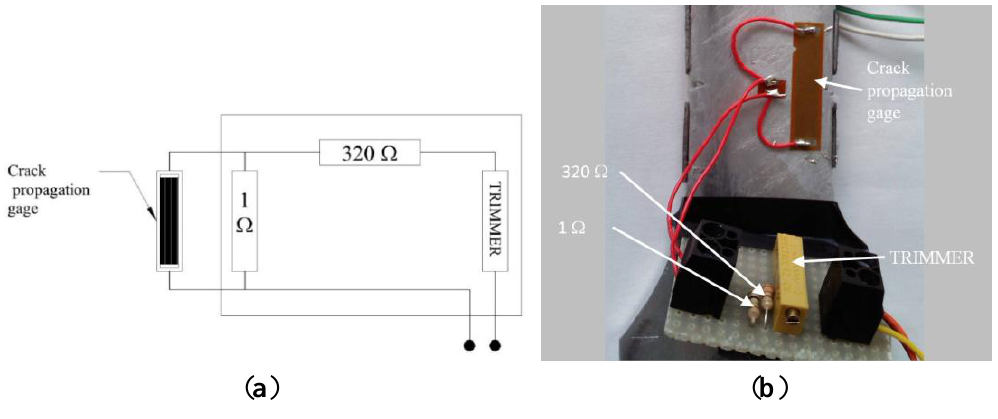
Figure 8. ( a ) Sketch of the electrical circuit including the CPG; and ( b ) picture showing the circuit assembled with the indication of each component.